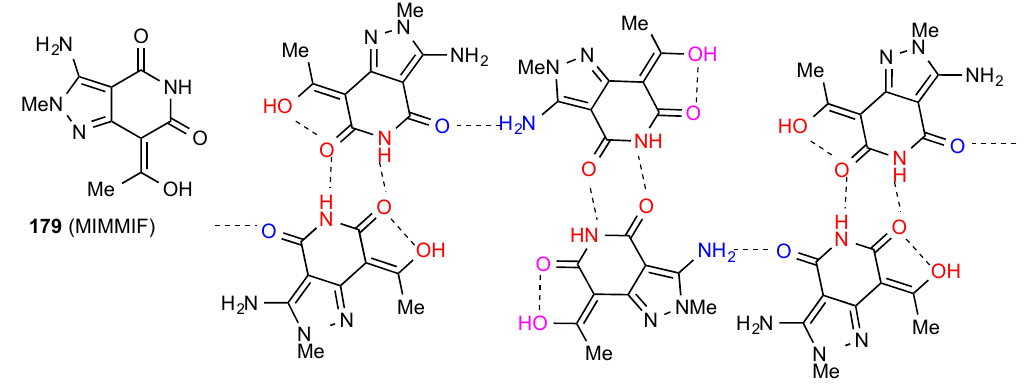
Figure 55. Structure adopted by compound 179.